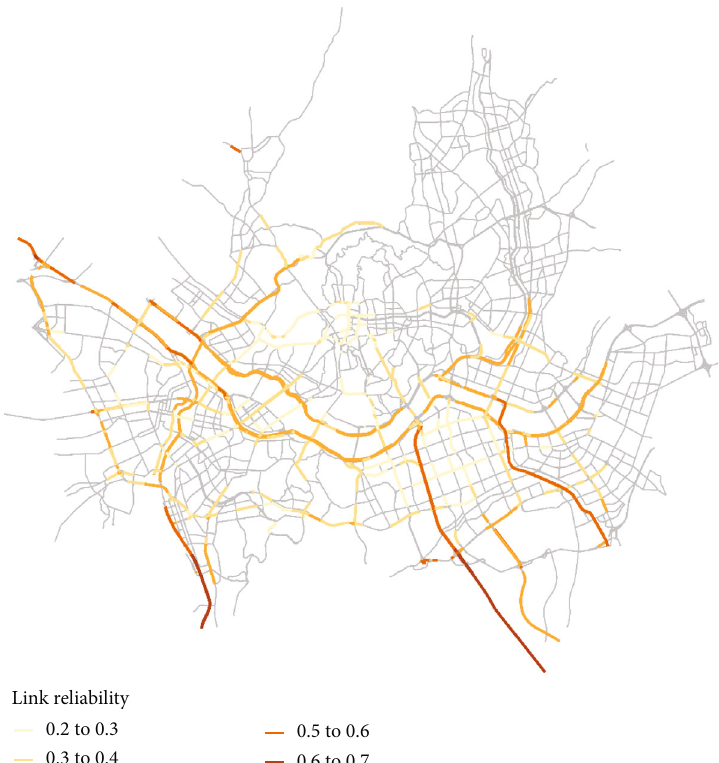
fi rst quartile load links in Seoul. Figure 8: lr i of the